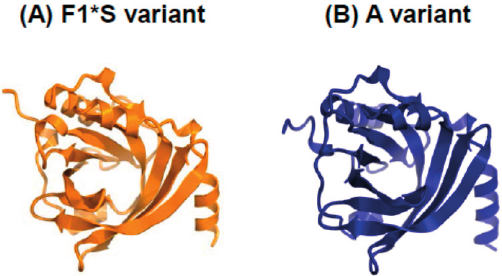
Figure 4. Crystal structures of the human AGP F1 * S ( A ) and A variants ( B ) at a resolution atomic coordinates from the Protein Data Bank, 3KQ0 for ( A ) and 3APX for ( B